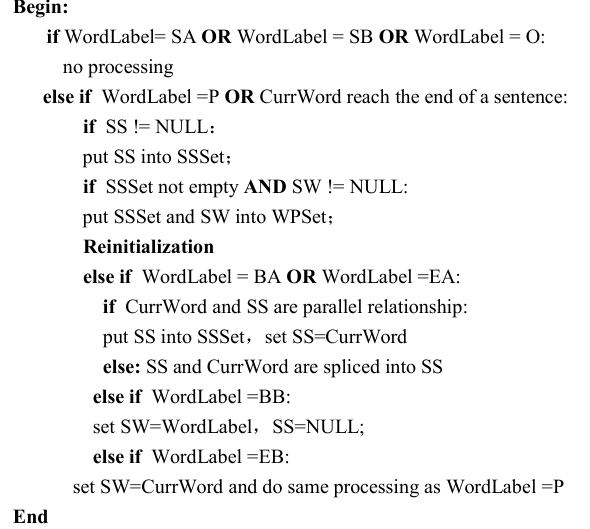
Algorithm : hierarchical filtering errors with